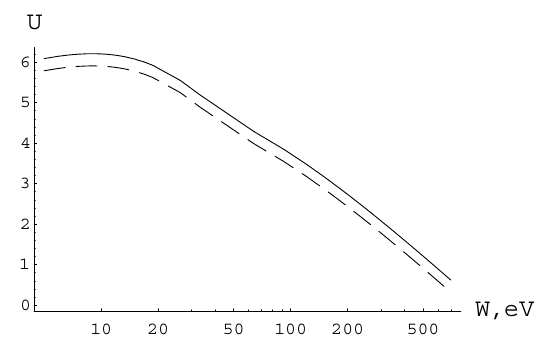
Fig. 1. Source-cone distribution function of photoelectron fluxes on closed magnetic field lines in the Martian ionosphere. Shown are the differential directional fluxes averaged over pitch angle (solid curve) and transverse fluxes (dashed) as functions of electron en- ergy. The curves are based on Eqs. (7) and (13). Both axes are in logarithmic